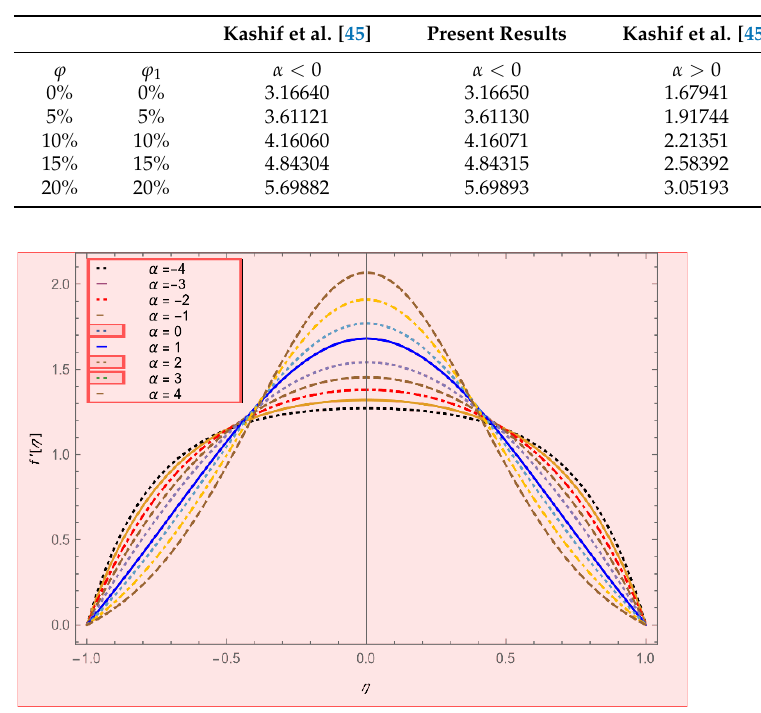
Figure 3. Concentration profiles for 𝜑 1 = 𝜑 2 = 0.01, 𝑆𝑐 = 1, 𝑀 = 1, 𝑅𝑒 = −1,𝑃𝑟 = 6.2 .